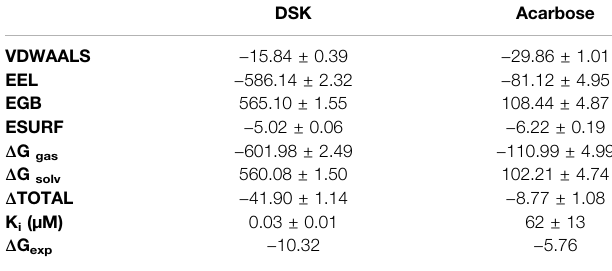
TABLE 3 | MM-PBSA